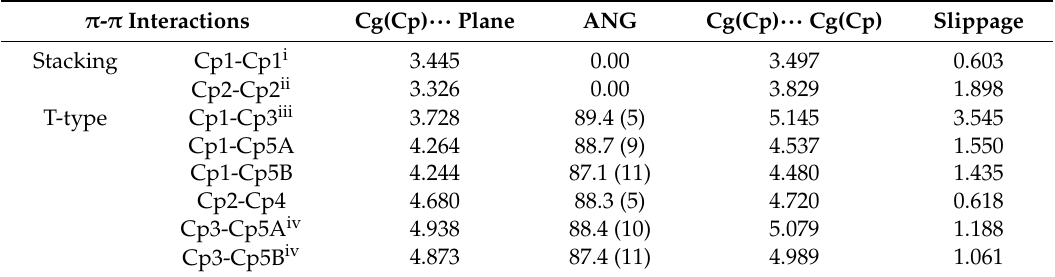
centroids. Slippage: distance between one centroid and its perpendicular projection to the plane containing the second ring. Symmetry codes: (i) − x, 1 − y, 1 − z; (ii) − x, − y, − z; (iii) − 1 + x, y, z; (iv) 1 + x, y,